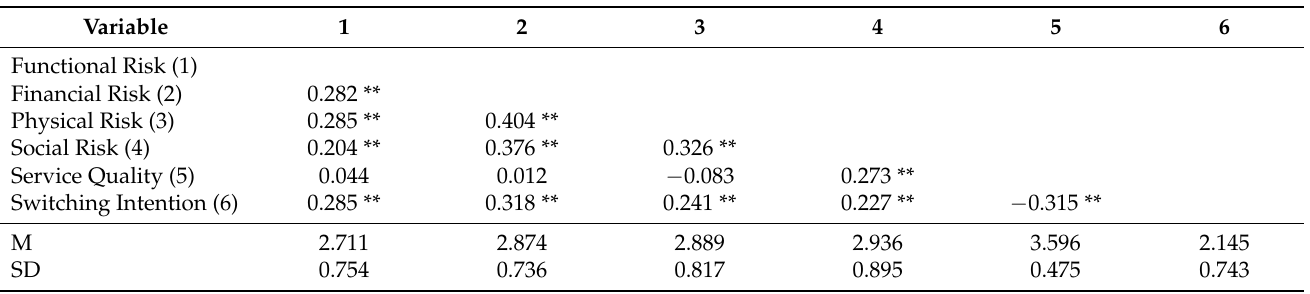
Table 5. Correlation coefficients between variables.